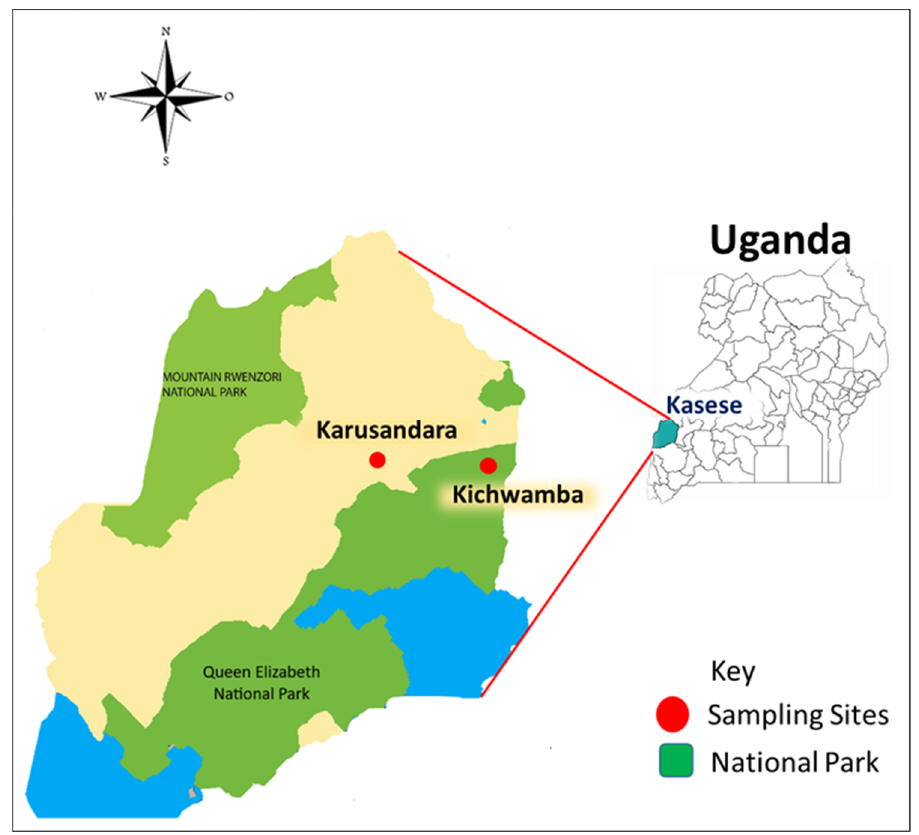
Figure 1. Map of Kasese district (located in western Uganda) showing the location of the two sampling subcounties (Karusandara and Kichwamba). The figure was generated and modified using GIMP 2.8.10 (https://www.gimp.org). Maps were obtained from d-maps.com (https://d-maps.com/index.php?lang=en).